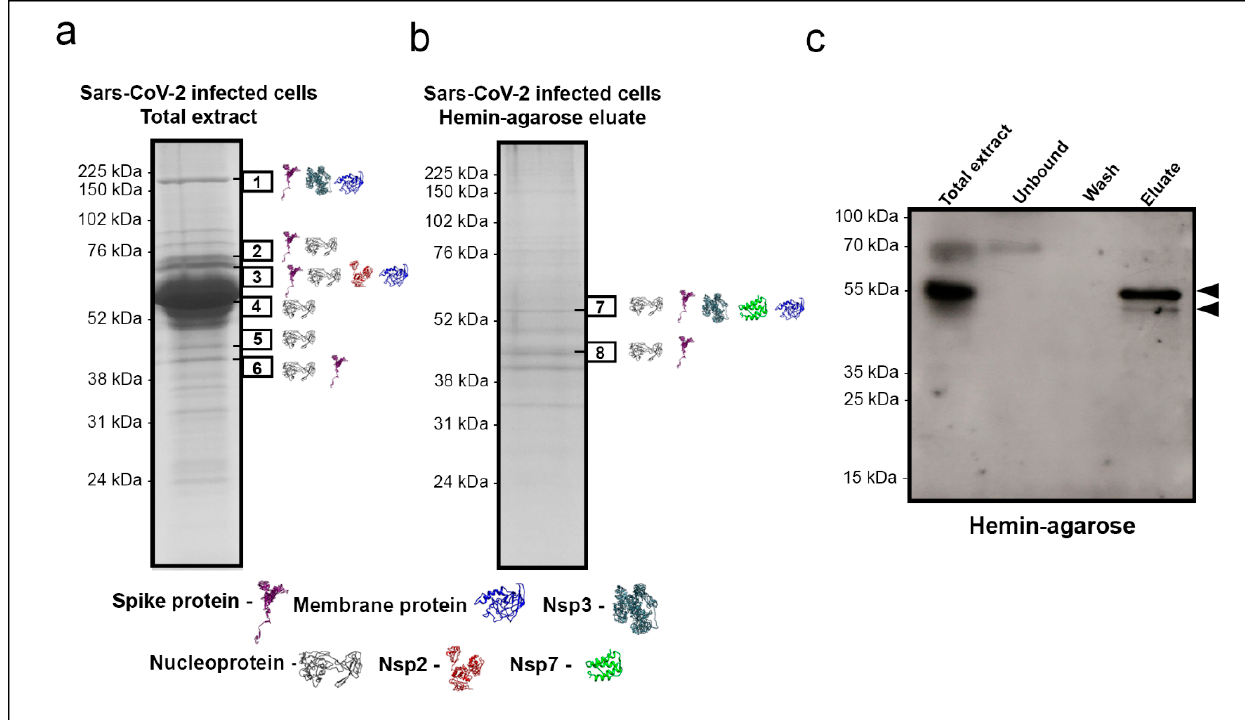
Figure 2. Heme affinity-purified proteins from total extracts of SARS-CoV-2 infected Vero cells and identification by mass spectrometry. SDS-PAGE resolved and Coomassie blue stained proteins: ( a ) whole virus-infected Vero cells extract and ( b ) eluate from a hemin-agarose column purification (after albumin depletion). Bands excised for protein identification by LC–MS/MS are indicated by black boxes 1–8. The proteins identified were N (P0DTC9), M (P0DTC5), S (P0DTC2), and replicase polyprotein 1a/1ab (P0DTC1/P0DTD1). The peptides in the replicase polyprotein 1a/1ab were identified as Nsp2, Nsp3, and Nsp7. The identified proteins in each band are shown as 3D structures retrieved from the I-TASSER site (https://zhanglab.ccmb.med.umich.edu/I-TASSER/, accessed on 20 September 2020). ( c ) Western blot revealed with COVID-19 patient convalescence sera pool ( n = 5); arrowheads indicate two bands showed in the